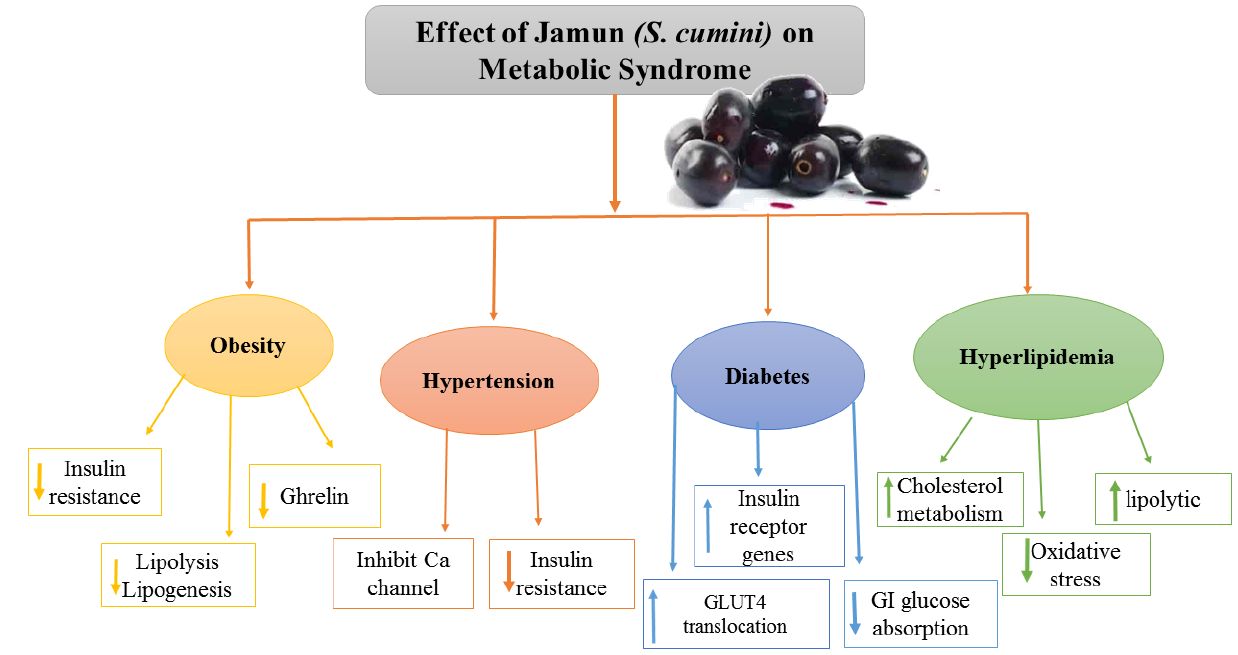
Figure 3. Effect of Jamun on metabolic